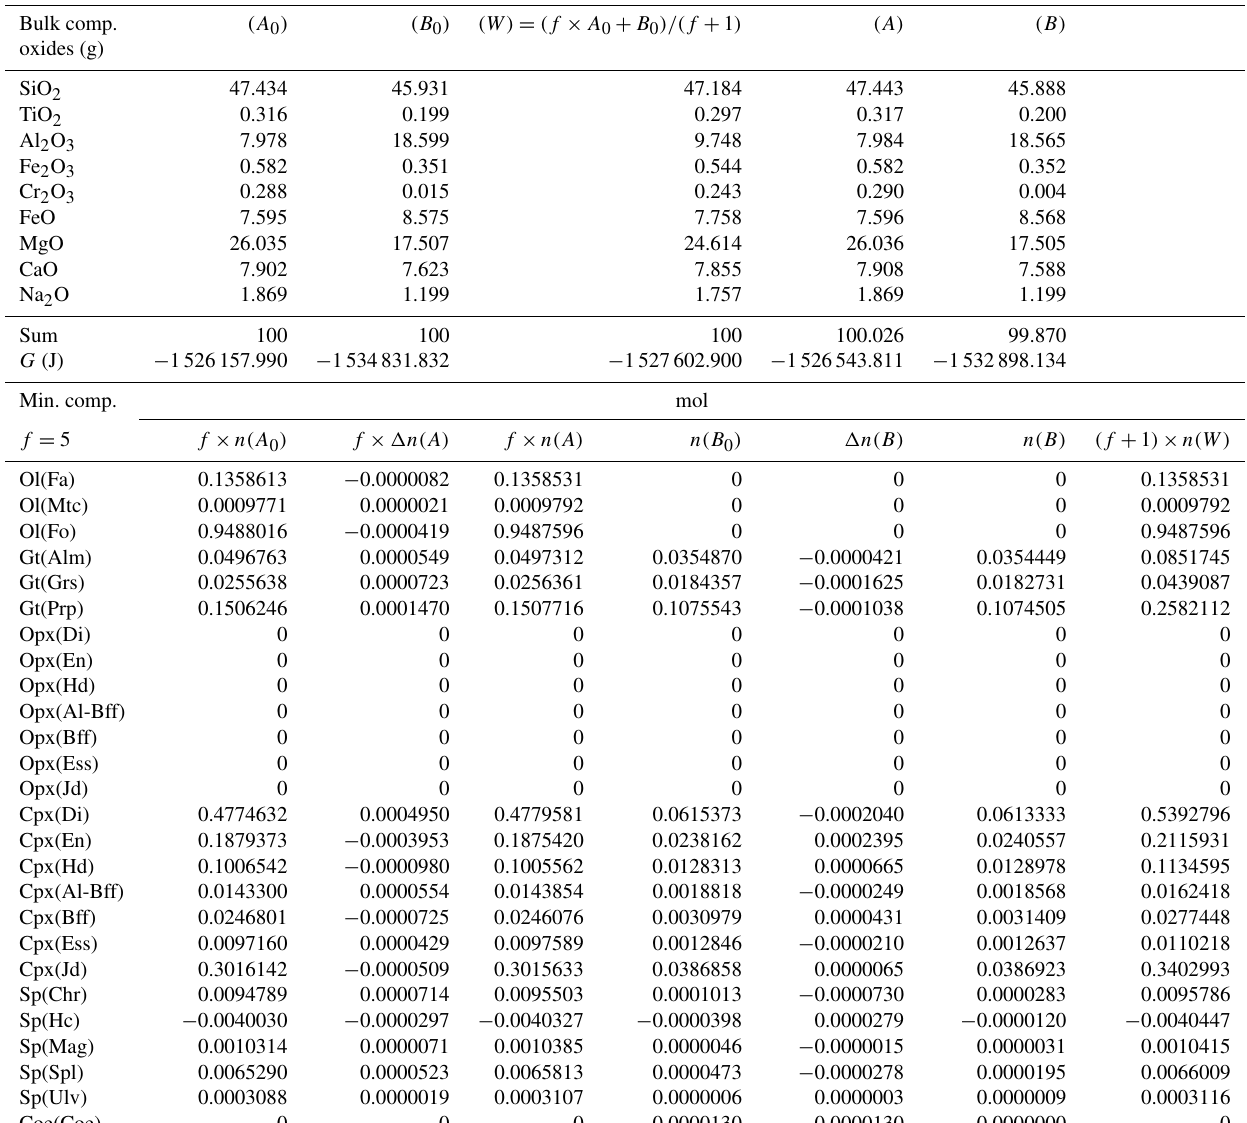
Table 5. Summary of the results of a chemical equilibration procedure in which the initial composition of the two subsystems ( A 0 ) and ( B 0 ) is taken from the outcome of the previous model ( A ∗ and B ∗ from Table 4). The initial proportion of the whole system is f : 1 ( f = 5). The description of the results follows the outline of the caption of Table